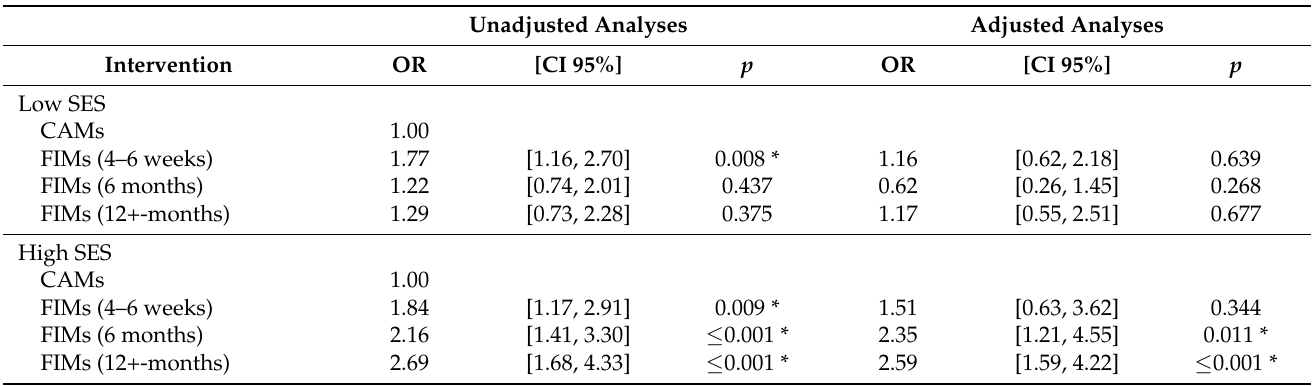
Table 3. Unadjusted and adjusted logistic regression analysis of the effect (successful quitting) in the financial incentives municipalities (FIMs) compared with the campaign municipalities (CAMs) at the end of the intervention, and after 6 and 12+-months. The results are based on the intention-to-treat principle and stratified by socioeconomic status (SES). OR: odds ratio, CI: confidence interval. Unadjusted Analyses Adjusted